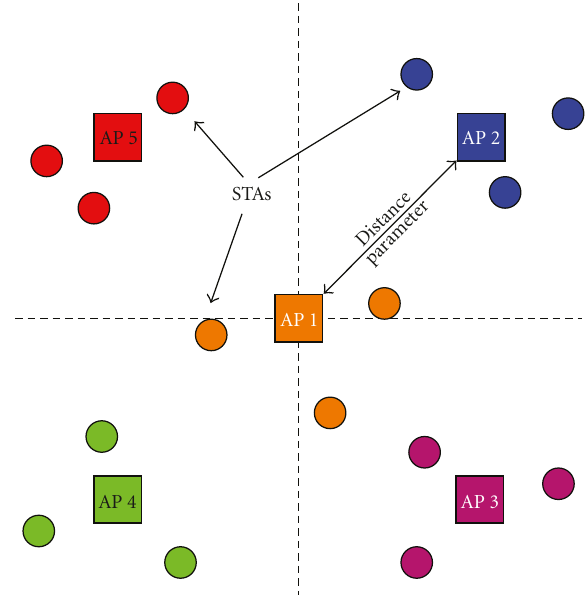
Figure 6: Topology for adjacent channel interference scenarios.